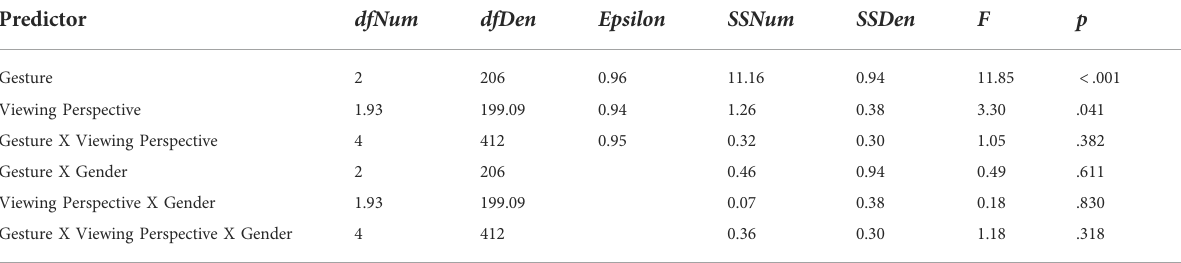
Gesture 1.94 Viewing Perspective Gesture X Viewing Perspective Gesture X Gender Viewing Perspective X Gender Gesture X Viewing Perspective X Gender